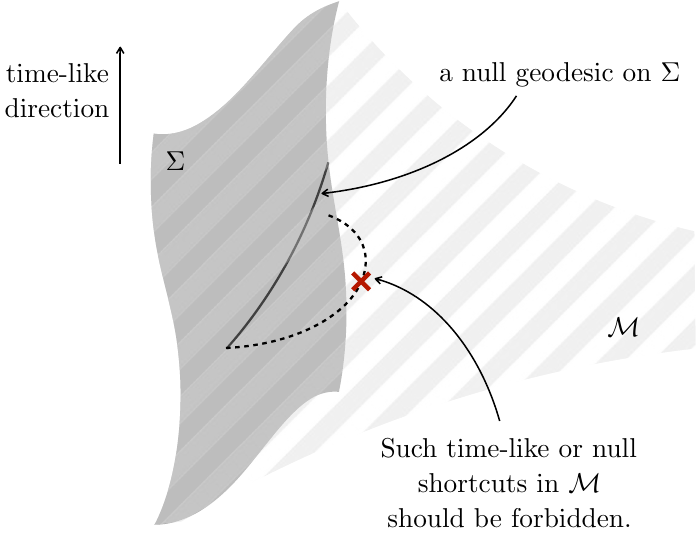
Figure 2 . No shortcut should be allowed in the bulk M (shaded) when considering signal prop- agations on the asymptotic boundary Σ (shown in grey). The solid line shows a null geodesic on Σ . The dashed line shows a time-like/null geodesic in M connecting two space-like separated (with respect to Σ ) points on Σ , which should not have